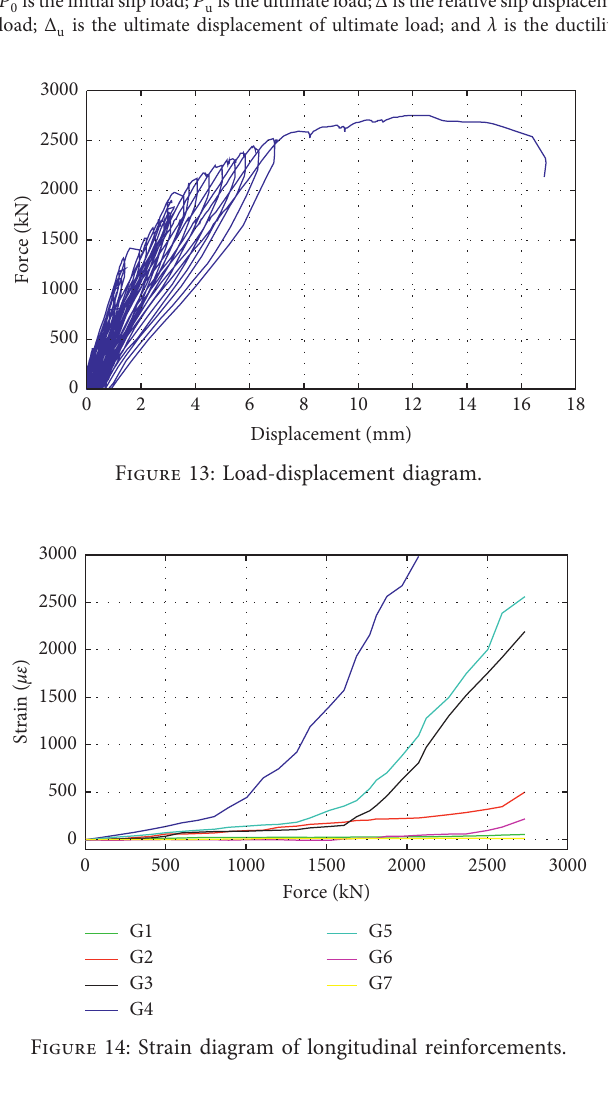
Figure 16: Strain diagram of planting